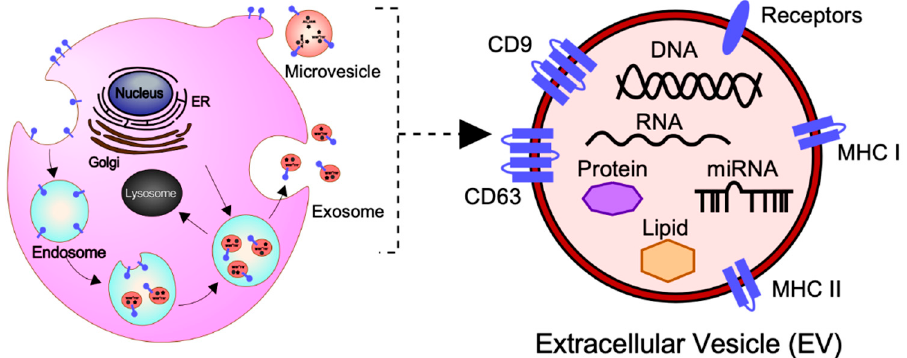
Figure 1. Biogenesis, secretion, and cargo of exosomes and microvesicles (MVs). Exosomes are small membrane-bound vesicles with a diameter of 50–150 nm, which are derived from endosomal multivesicular bodies. MVs are released directly from the plasma membrane with a diameter of 100–1000 nm into the extracellular space by budding and fission. Exosomes and MVs contain a variety of bioactive molecules including soluble and membrane-bound protein, lipids, metabolites, DNA, and RNA (mRNA, miRNAs, and other small regulatory RNAs), which regulate cellular activities of the recipient cells.